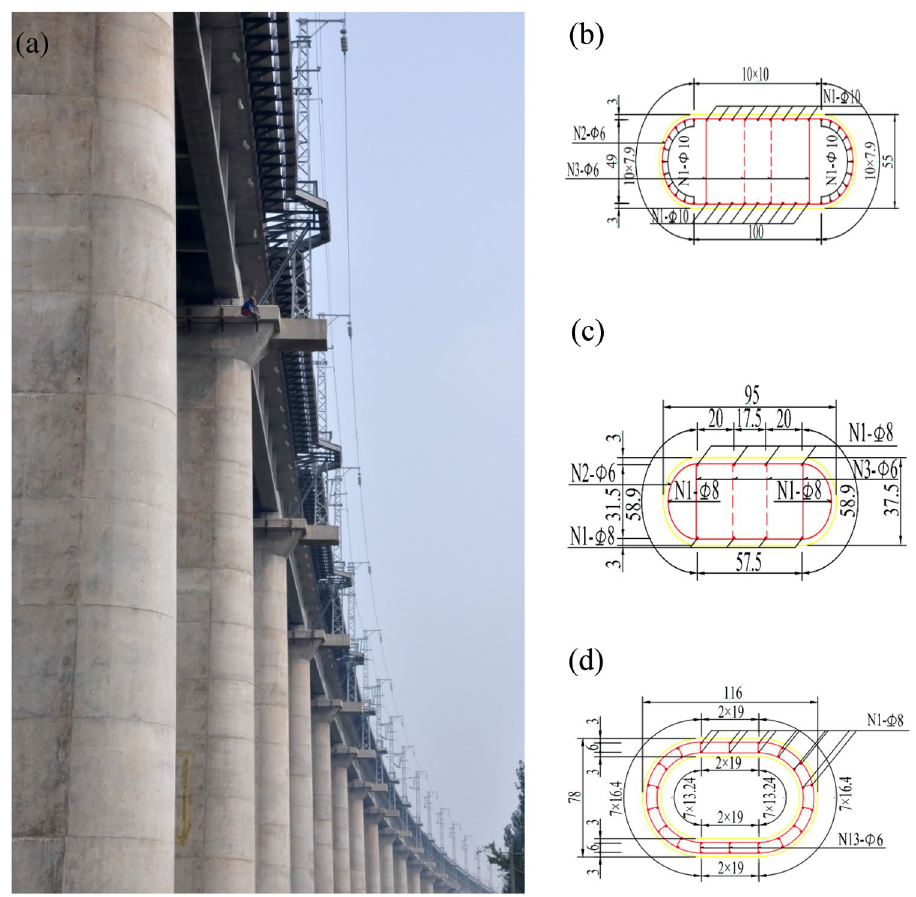
Figure 1. RERS cross-section piers used in HSRBs. ( a ) The bridge with RERS cross-section piers; ( b ) section of a 10 m high concrete pier, ( c ) section of an 18 m high concrete pier; and ( d ) round-ended part of a 30 m high hollow pier. Image by Dr. Lingkun